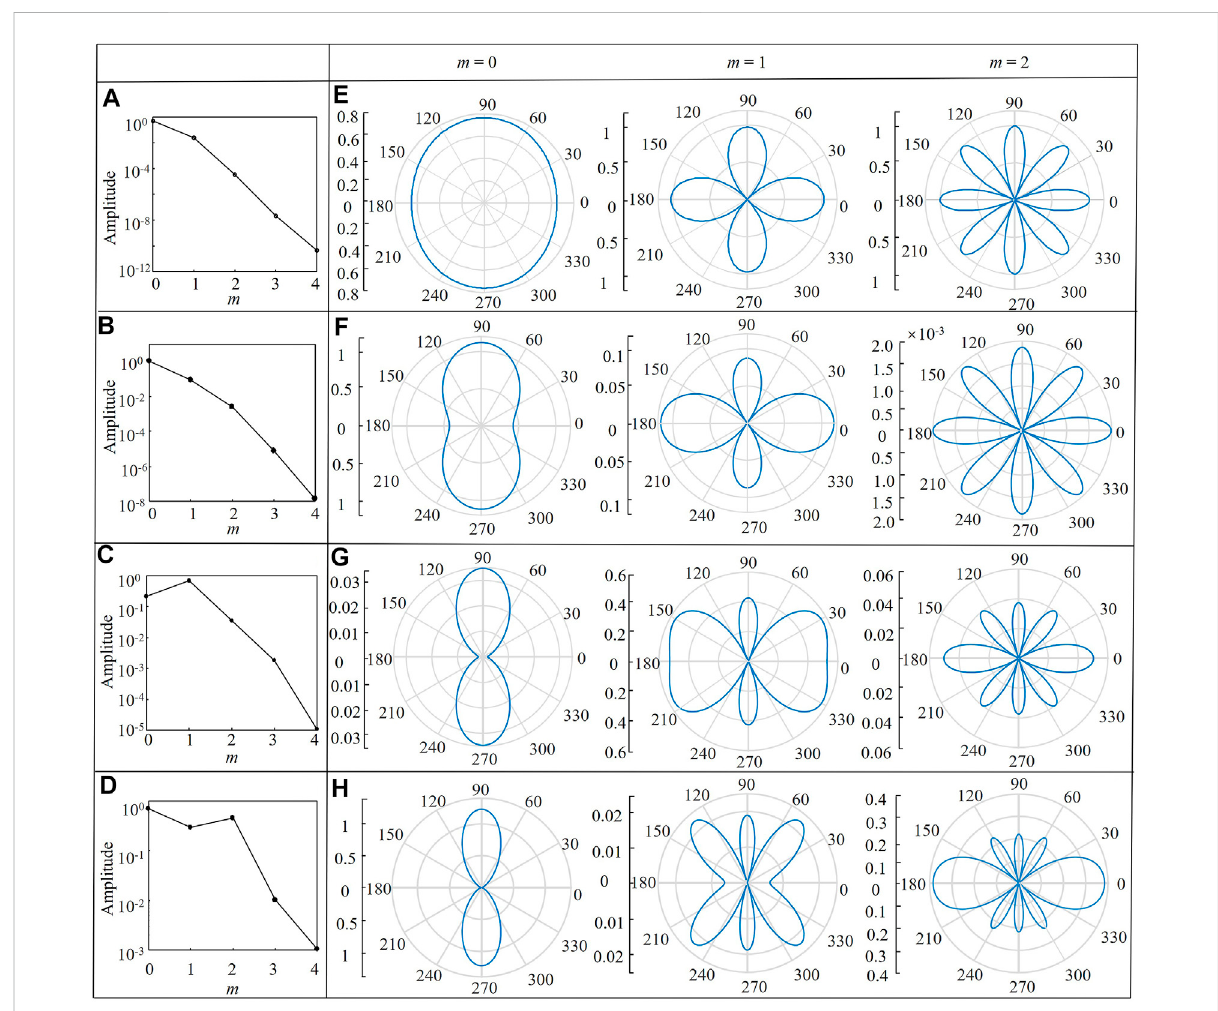
Near- fi eld contribution of various modes for photoacoustic wave with various frequencies. (A – D) Mode contribution coef fi cients for 40, 100, 200, and 300 MHz. (E – H) The mode polar distribution patterns of the three lowest modes for each